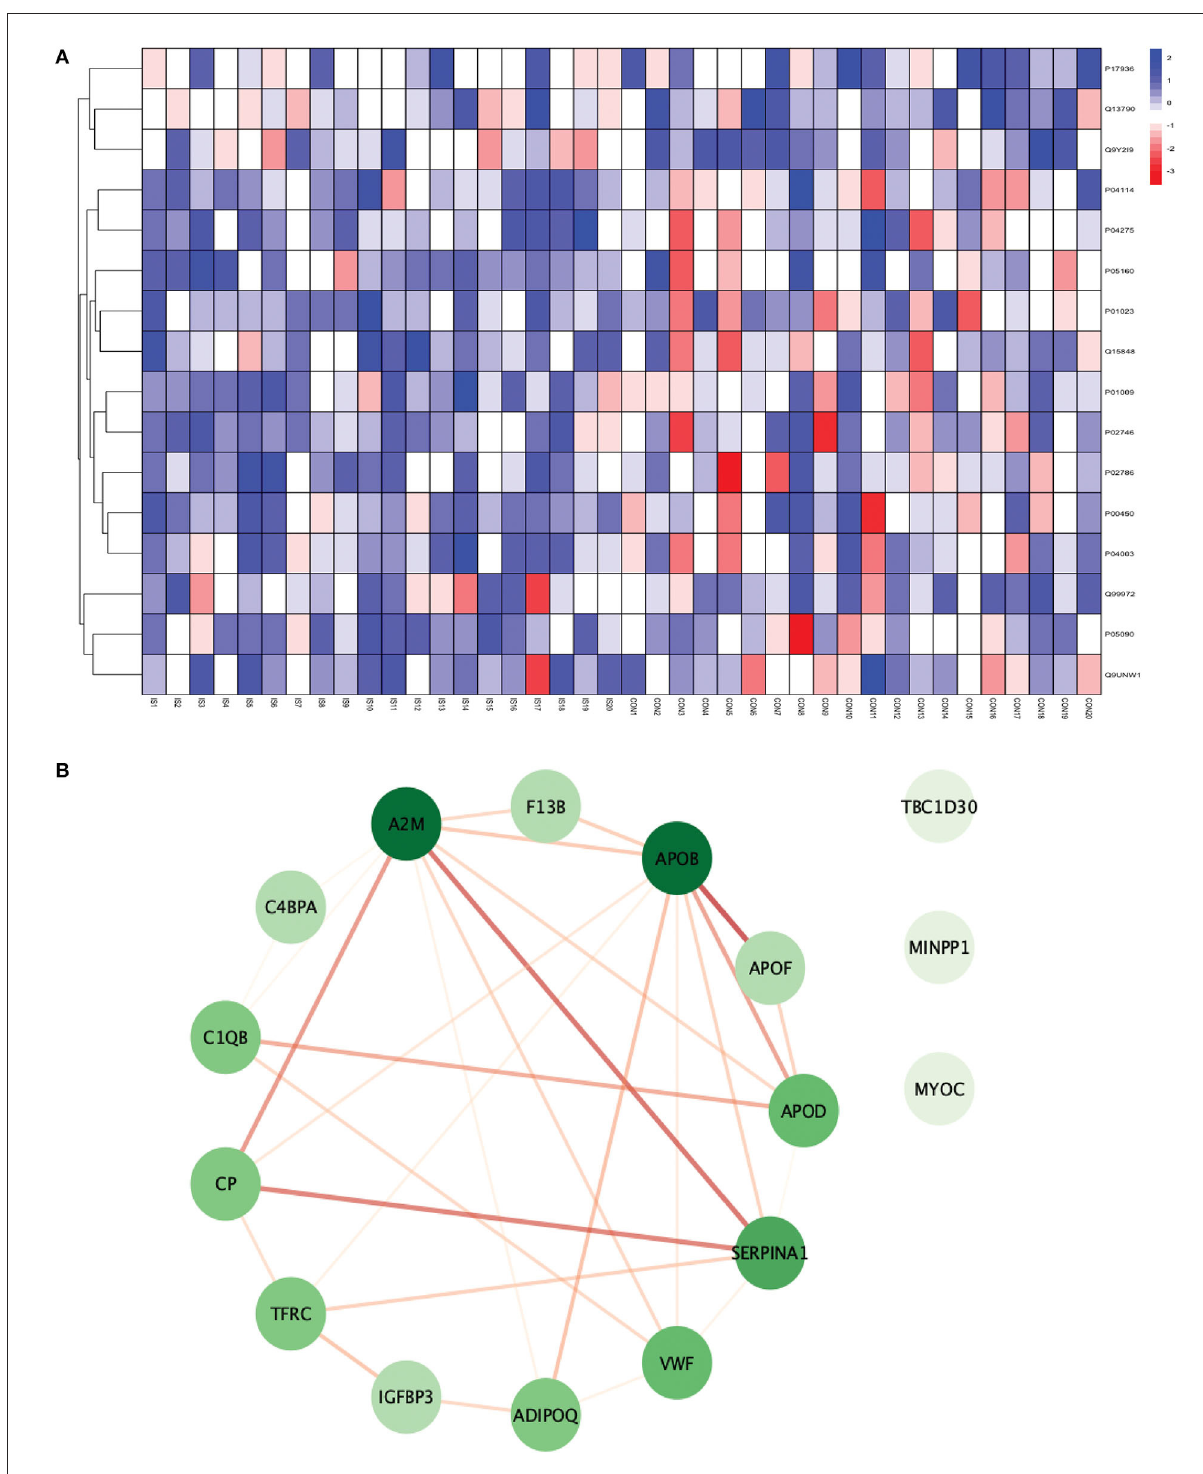
FIGURE6 (A) Heatmap showing the distribution and expression pattern of 16 significantly differentially expressed proteins between IS and healthy controls. (B) Protein–protein interaction network analysis of differentially expressed proteins between IS and healthy